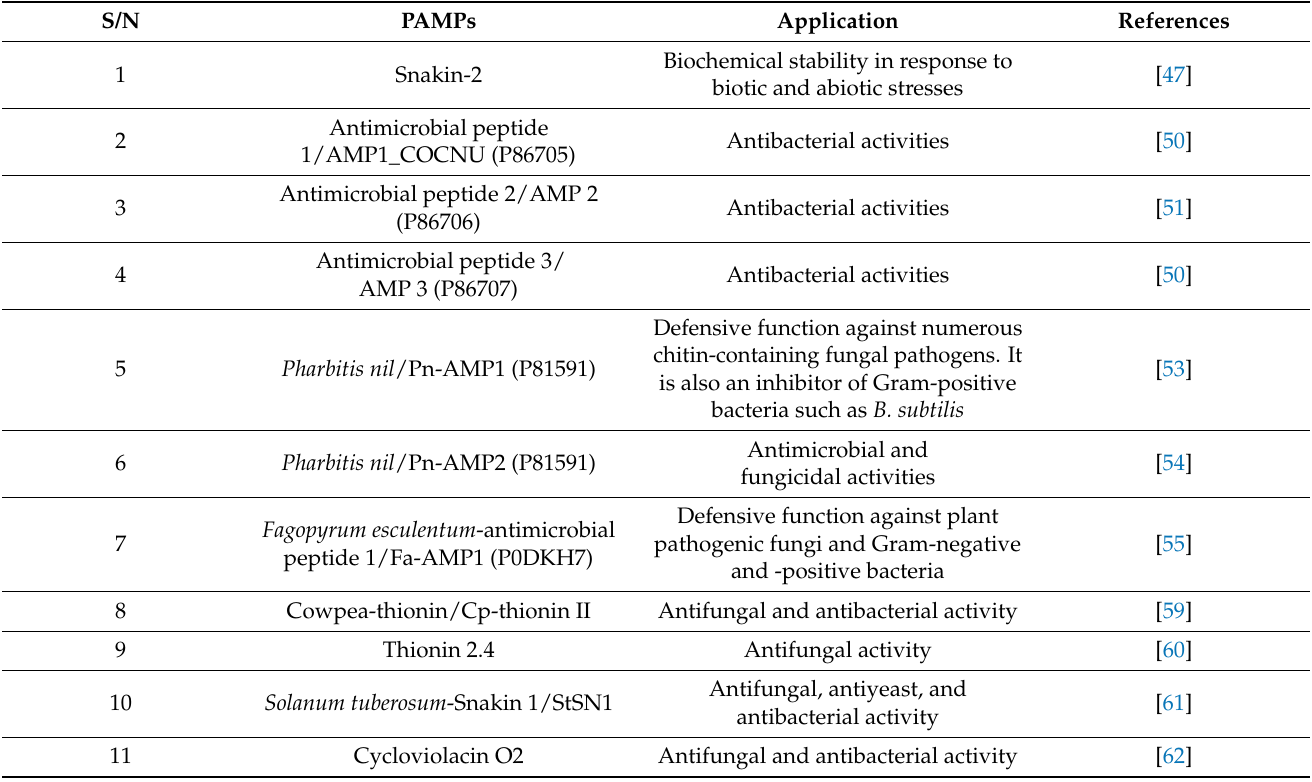
Table 2. Applications of PAMPs in